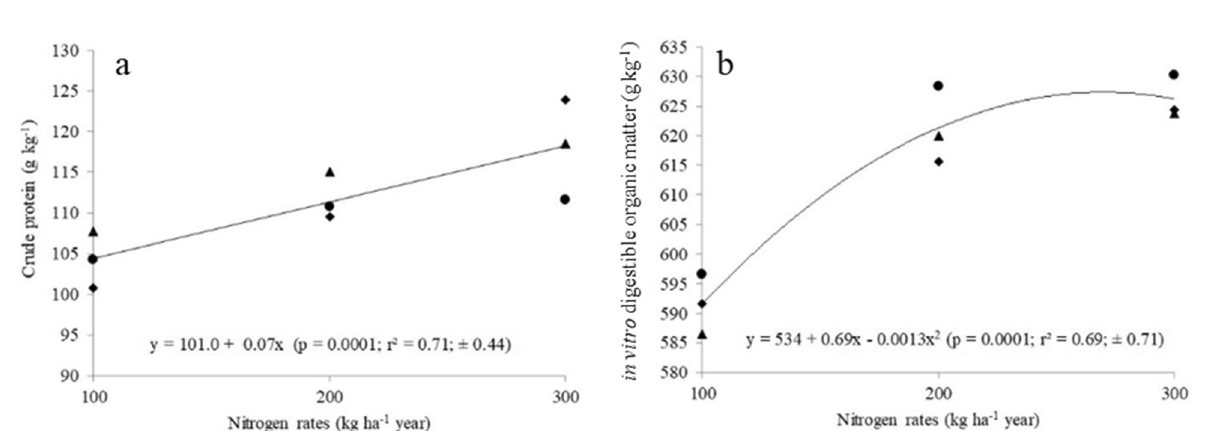
Figure 2. Effect of nitrogen on crude protein ( a ) concentration and in vitro digestible organic matter ( b ) percentage of leaves of P. maximum cv. Mombaça guinea grass pastures subjected to rotational stocking and nitrogen rates ( ● year 1; ♦ year 2; ▲ year 3).